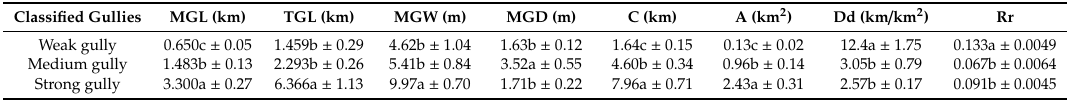
Figure 5. Principal component analysis (PCA) of gully developmental characteristics. Table 3. Gully developmental